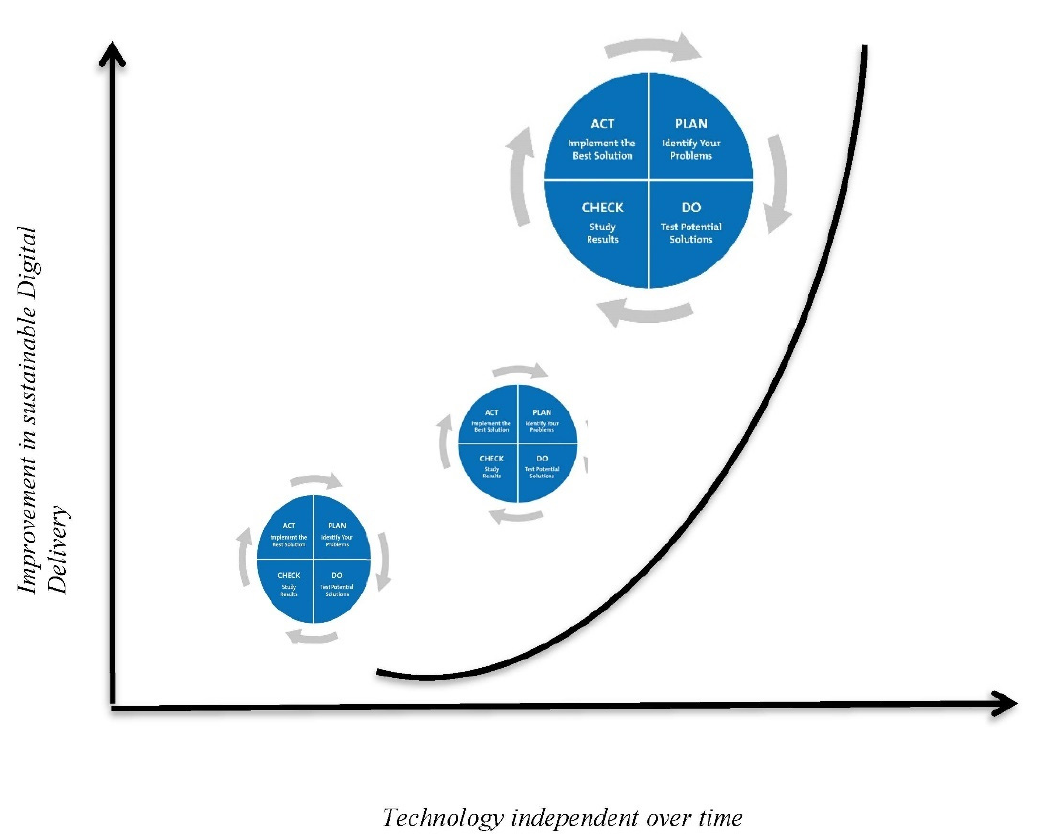
Figure 12. Incremental Improvement of Sustainable Digital Delivery. Source: Based on Demenko and Savina (2019).